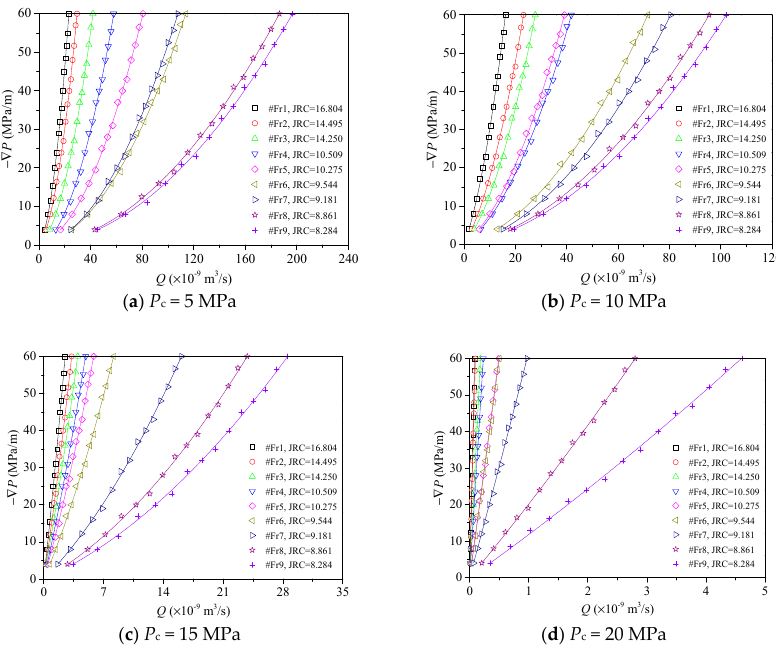
Figure 5. Relations between volume flow rate and pressure gradient of the rough-walled fractures.